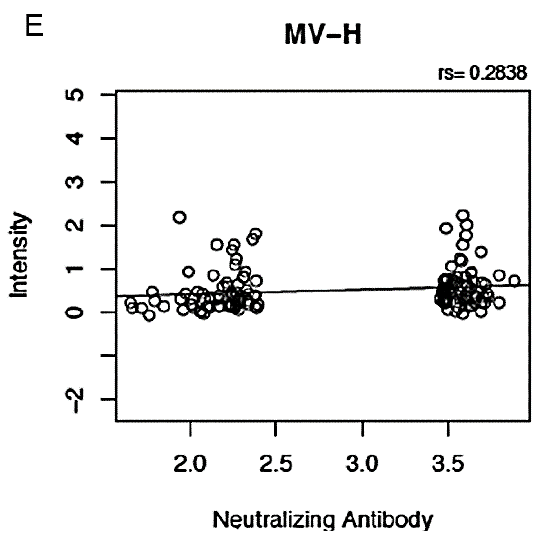
Figure 2. Correlation between proteome microarray antibody measurements and neutralizing antibody response. Panels ( A ), ( B ), ( C ), ( D ) and ( E ) illustrate the positive correlations between microarray measurements against MV-P, MV-N, MV-L-s3, MV-F and MV-H proteins, respectively (presented as log 2 normalized signal intensity values), on the y-axis and neutralizing antibody response (presented as log 2 value of the PRMN mIU/mL titer). “rs” indicates Spearman’s correlation